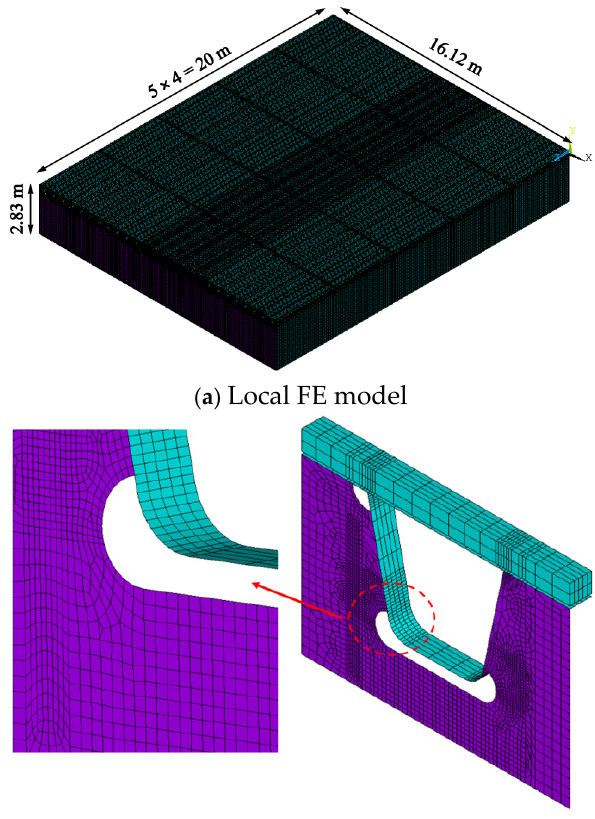
Figure 2. FE model of LWCD.